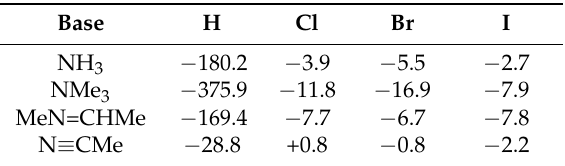
Change in C-Z stretching vibration frequency (cm − 1 ) in ImZ + Lewis acid caused by complexation.